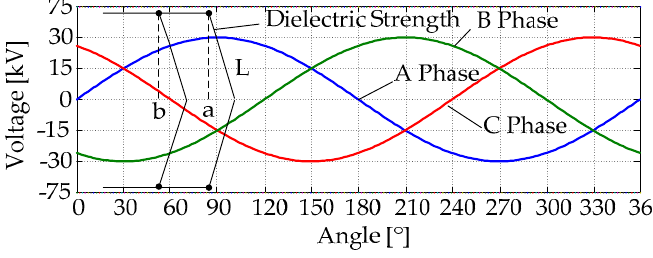
Figure 9. The relationship between the initial closing angle and overvoltage.